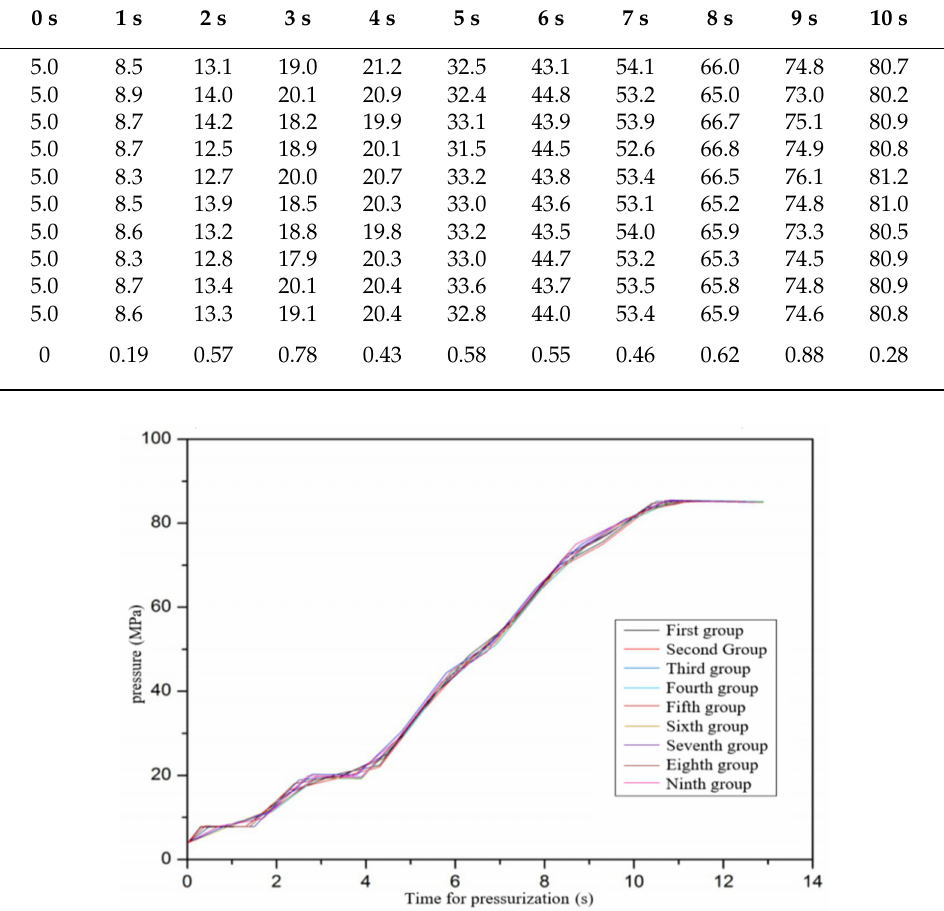
Figure 17. Pressure in the hose changes with pressurization